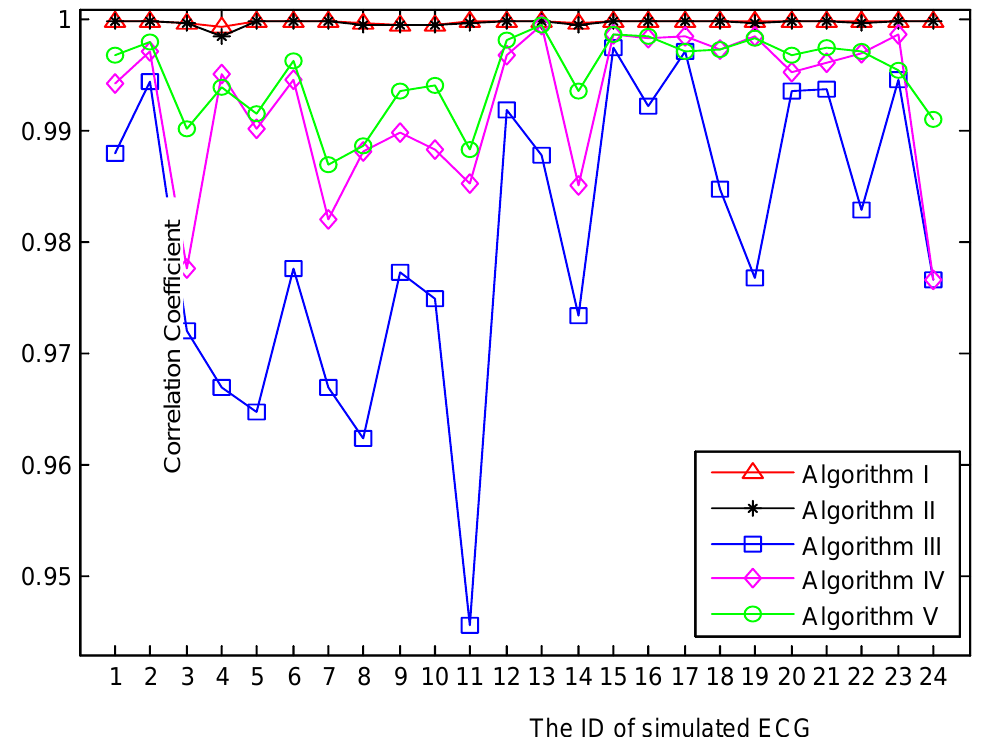
Figure 9. Comparison of five algorithms using the correlation coefficient between ‘retrieved’ and ‘clean’ ECG.